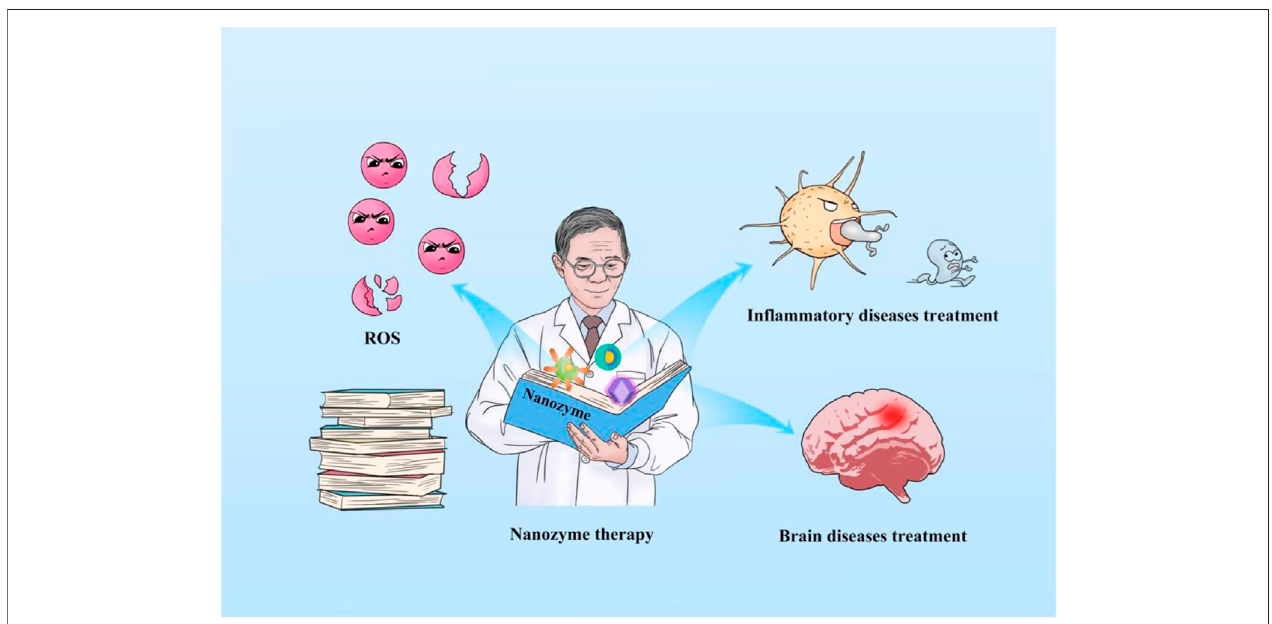
FIGURE 2 | Schematic illustrating the review of nanozyme-based nanotherapy for eliminating ROS and regulating redox homeostasis, ultimately treating in fl ammation and brain diseases.